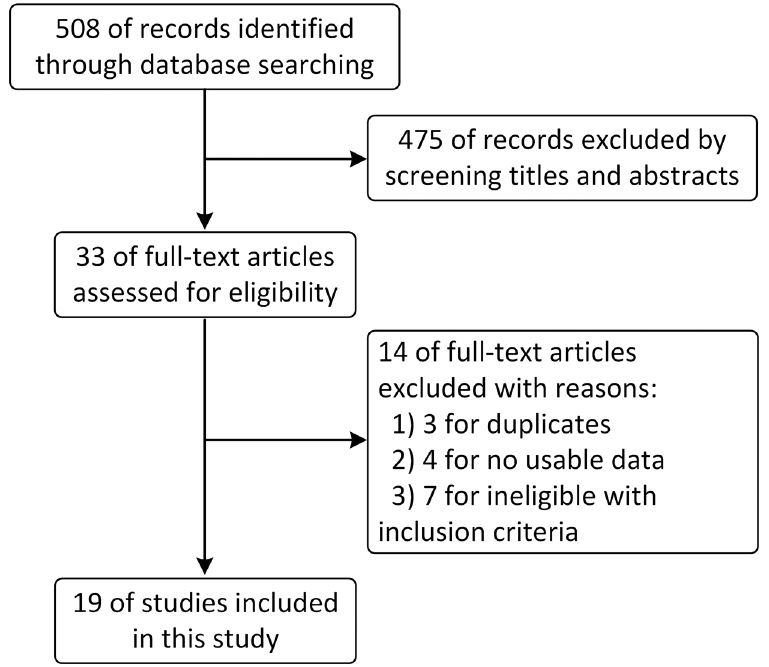
Fig 1. Flowchart of this systematic